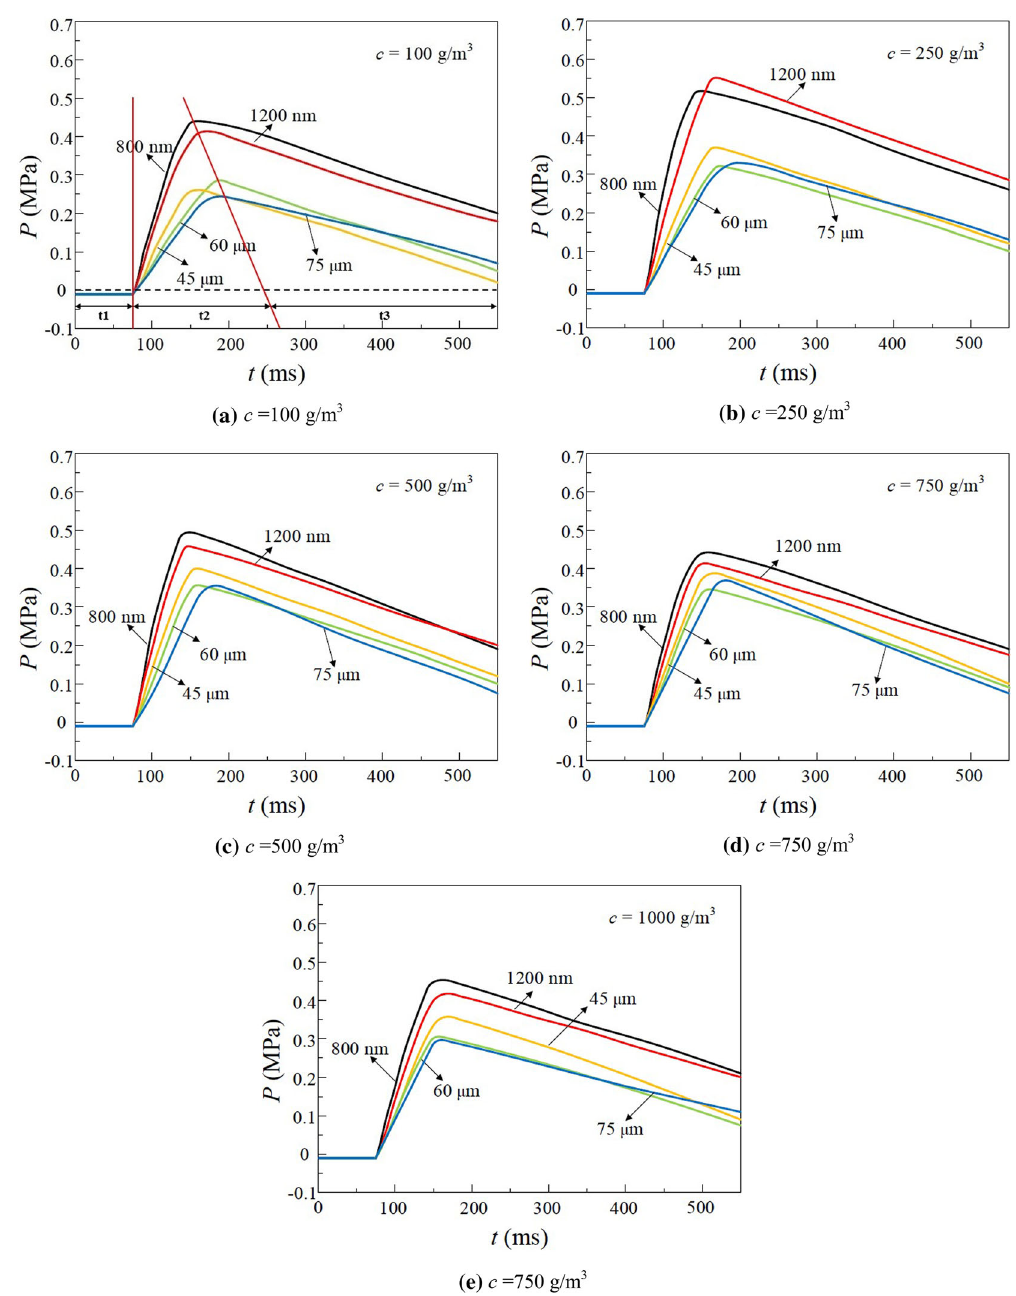
Fig. 6 Coal dust explosion pressure–time